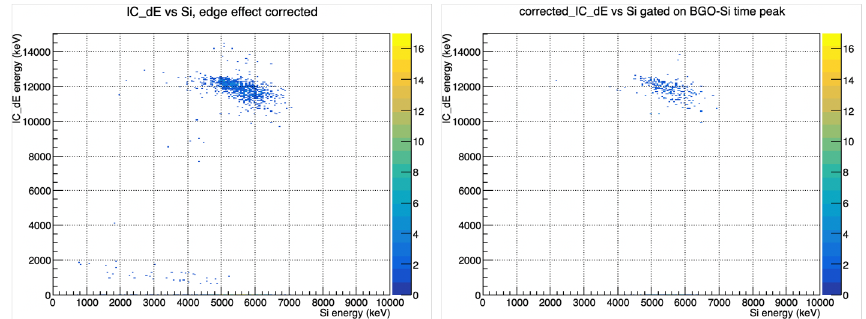
Figure 3. Left: All ions reaching the final focal plane measured with the IC and DSSD detectors ( ∆ E-E) when SECAR was tuned to the 8 + charge state of the 20 Ne recoils. Three distinctive groups of ions are observed corresponding to recoils and "leaky beam" particles. Right: Same as the left plot, but with the events gated on the BGO - Si time di ff erence peak corresponding to the recoil ToF between the target and the FP4.